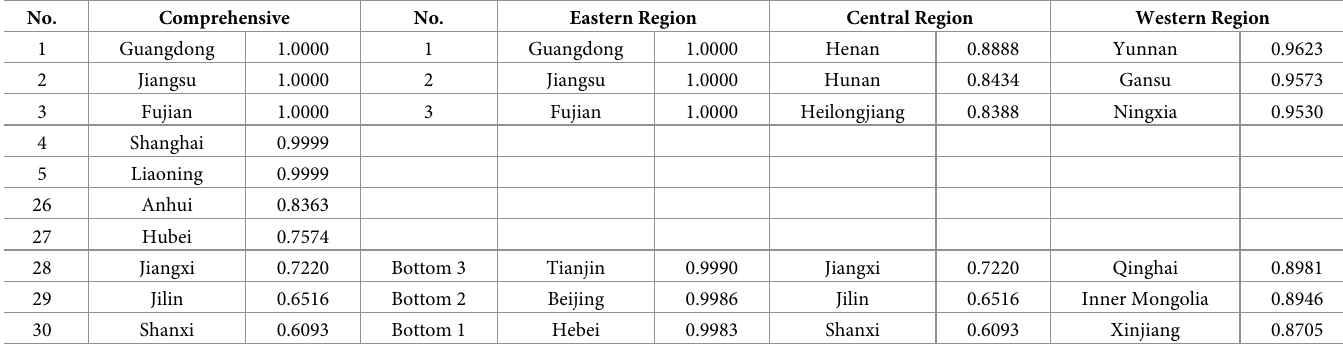
Table 2. TGR ranking of some